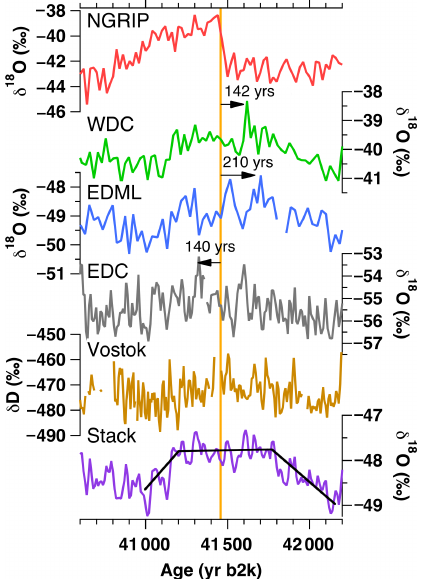
Figure 8. Phasing between the GS–GIS transition in Greenland (vertical orange line) and the maximum of the AIM 10 in 4 differ- ent Antarctic ice cores on the GICC05 age scale. The synchronic- ity between Vostok, EDC, EDML and NGRIP is based on the 10 Be records while the WDC isotopic record has been drawn on the GICC05 timescale using the correspondence between the WSD timescale and GICC05 given in Buizert et al. (2015). A stack (pur- ple curve) is drawn using the 3 δ 18 O records from EDML, EDC and WDC, and the black lines correspond to its inflections identified by